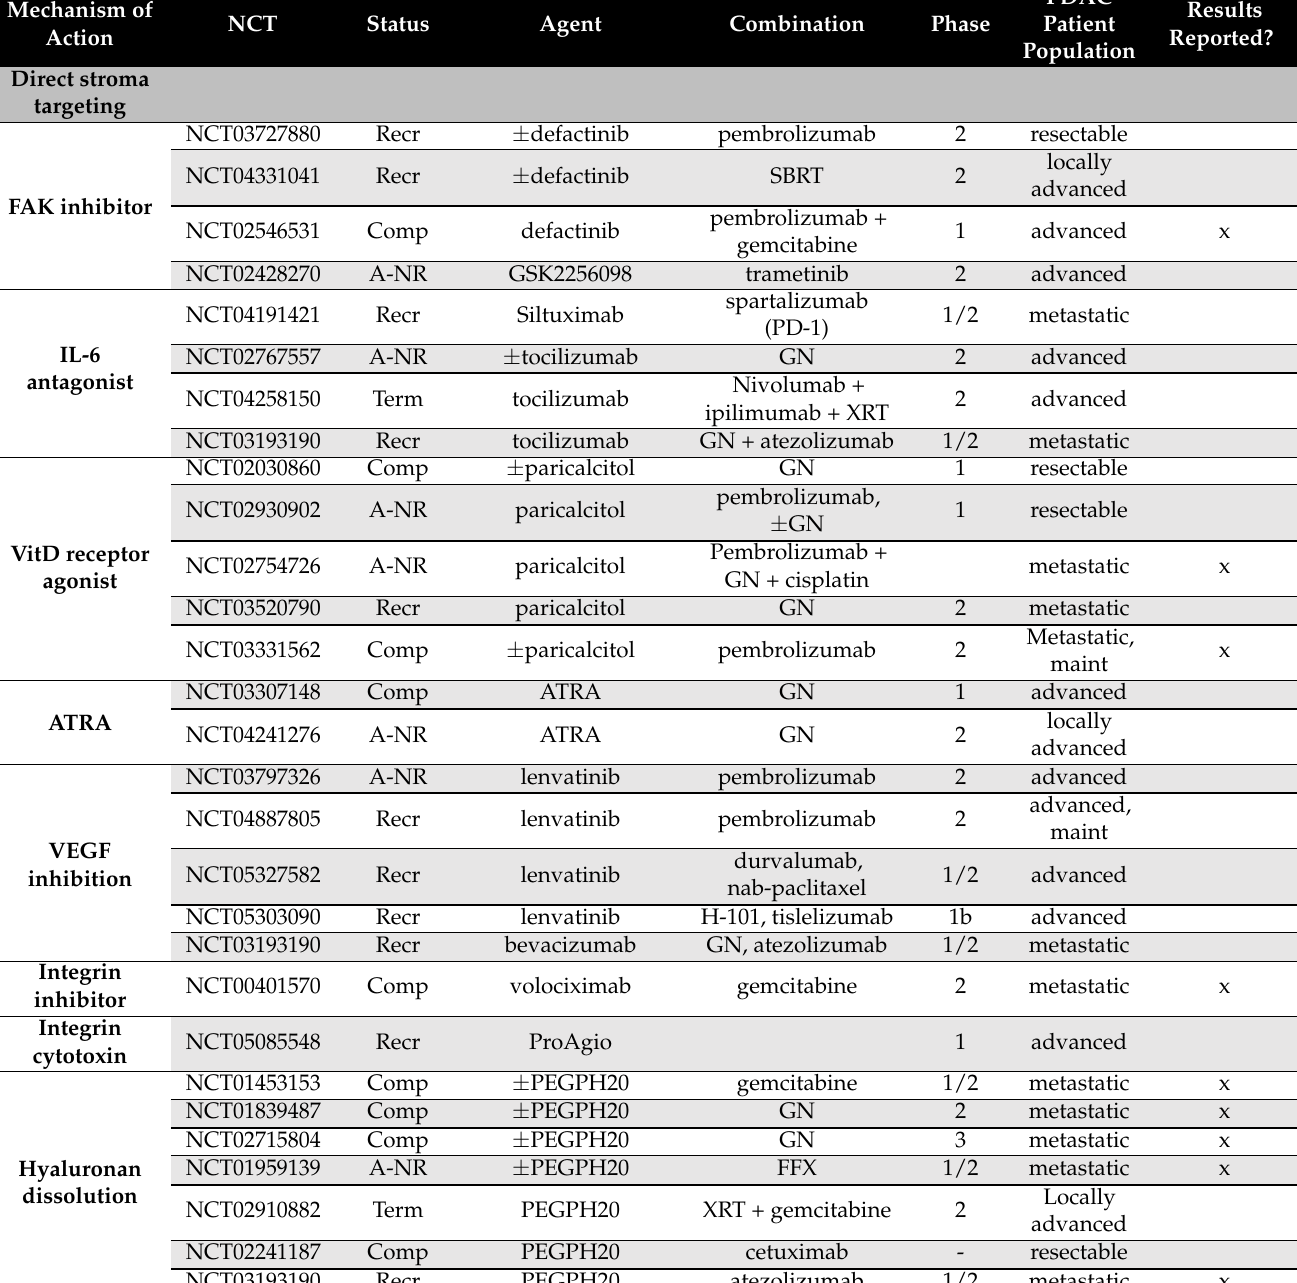
Table 2. Selected list of clinical trials in PDAC targeting stromal